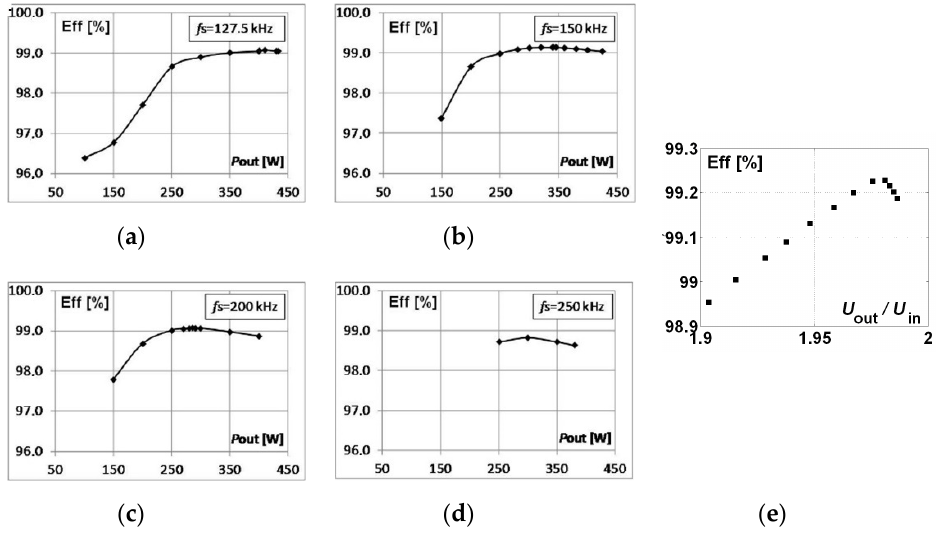
Figure 14. Efficiency of SCVD in CCM mode as a function of: ( a – d ) output power P out , ( e ) U out / U in at P out = 400 W. U in = 200 V, t M = 50 ns. Switching pattern P2.